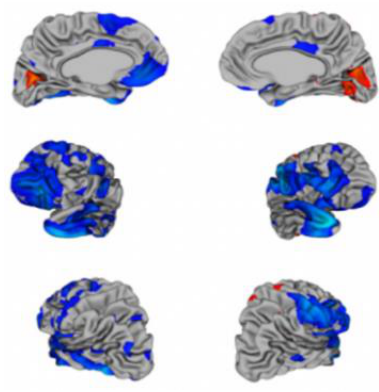
Figure 9. The brain structure variations in an autistic child .